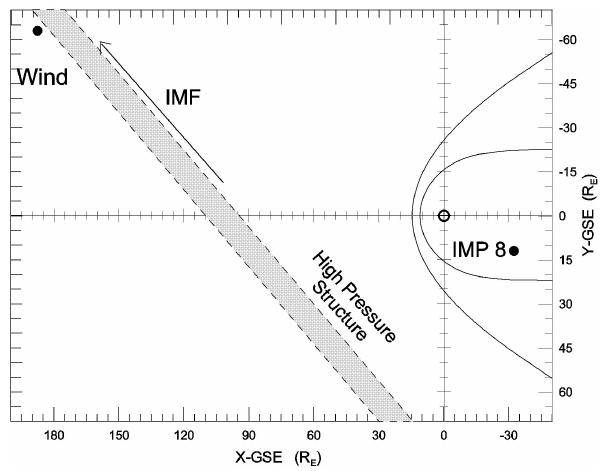
Fig. 7. Wind and IMP-8 positions, projected over the XY GSE plane, for the event of day 29, 1995. A high pressure structure in the solar wind is indicatively shown, as well as the direction of the IMF.